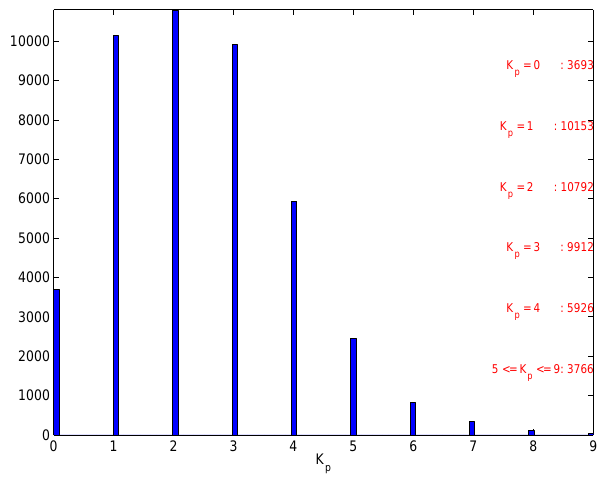
Fig. 5. Distribution of overflights as a function of K p and the num- ber of overflights in the K p